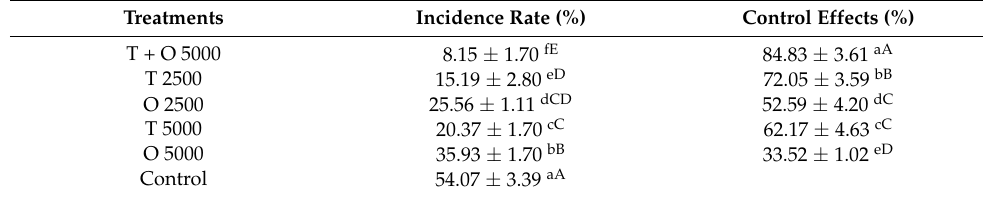
Table 4. The field control effects of tebuconazole and oligosaccharins on kiwifruit soft rot.